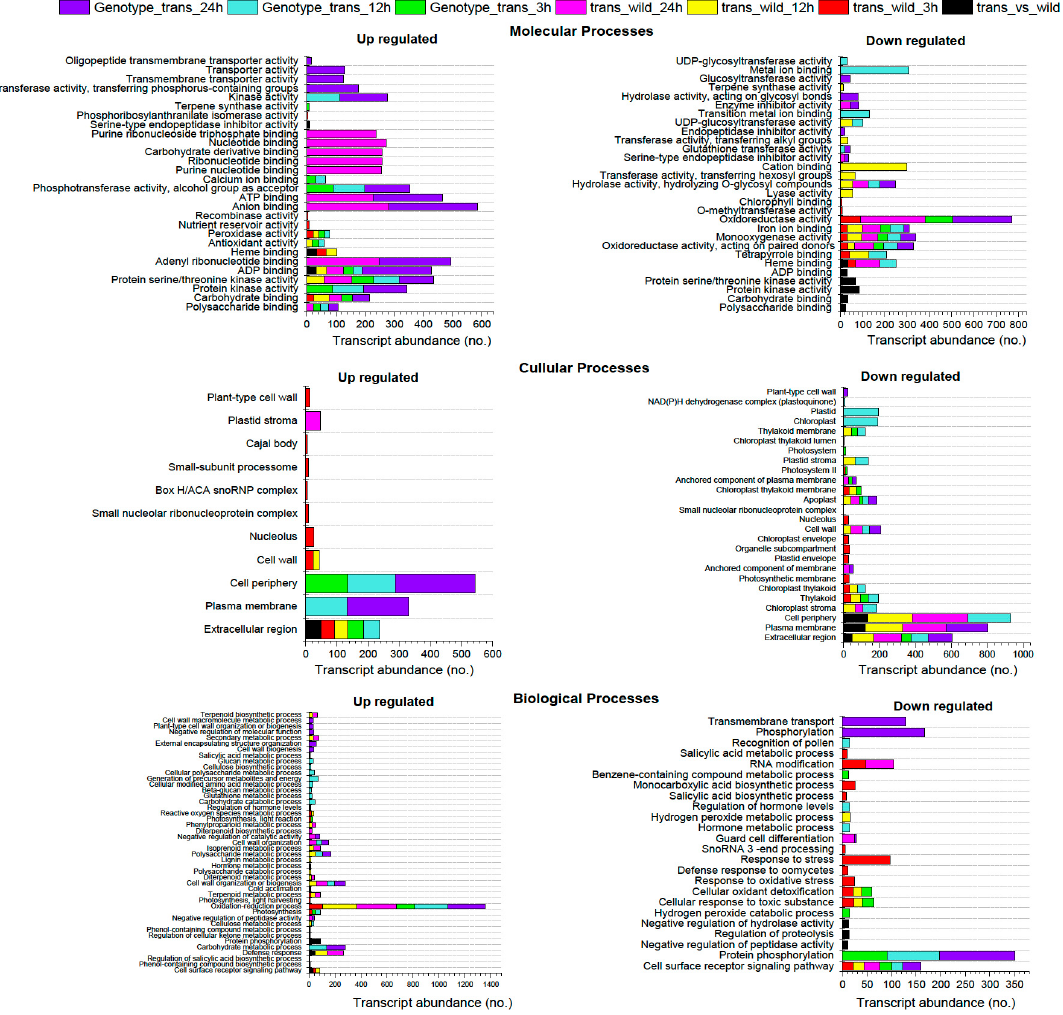
Figure 3. The abundance of transcripts of pathways under biological processes, cellular processes, and molecular processes in differential expression groups in OxF3H plants infested with WBPH at different time points. The different colors show different comparisons used in Deseq2 analysis.